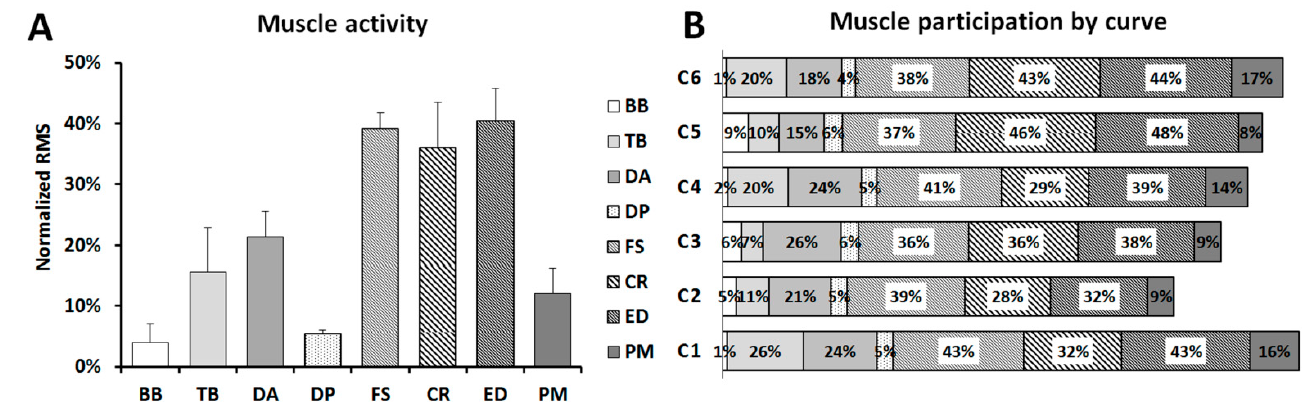
Figure 2. ( A ): Muscle activity of all analyzed curves for the first three laps. ( B ): Muscle participation during the first three laps for each curve. Values are mean and standard deviation.